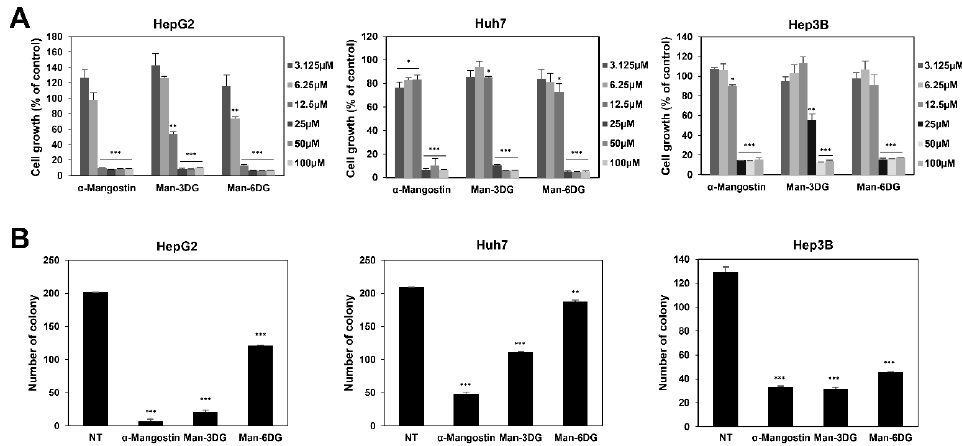
Figure 2. The growth-inhibitory e ff ects of α -mangostin glycosides on hepatocellular carcinoma (HCC) cells. ( A ) The e ff ects of α -mangostin, Man-3DG, and Man-6DG on the growth of HepG2, Huh7, and Hep3B cells. The cells were treated with increasing concentrations of three compounds (0–100 µ M) for 72 h, and cell growth was measured through the 3-(4,5-dimethylthiazol-2-yl)-2,5-diphenyltetrazolium bromide (MTT) assay. Data are presented as percentage relative to dimethyl sulfoxide (DMSO)-treated control (% of control). Each value represents the mean ± SD from three independent experiments. ( B ) The e ff ects of α -mangostin, Man-3DG, and Man-6DG on the colony forming ability of HepG2, Huh7, and Hep3B cells. The cells were incubated in the absence or presence of the three compounds (10 µ M) for 7 days. The cell colonies were detected through crystal violet staining. Each value represents the mean ± SD from three independent experiments. * p < 0.05, ** p < 0.01, and *** p < 0.001 versus the